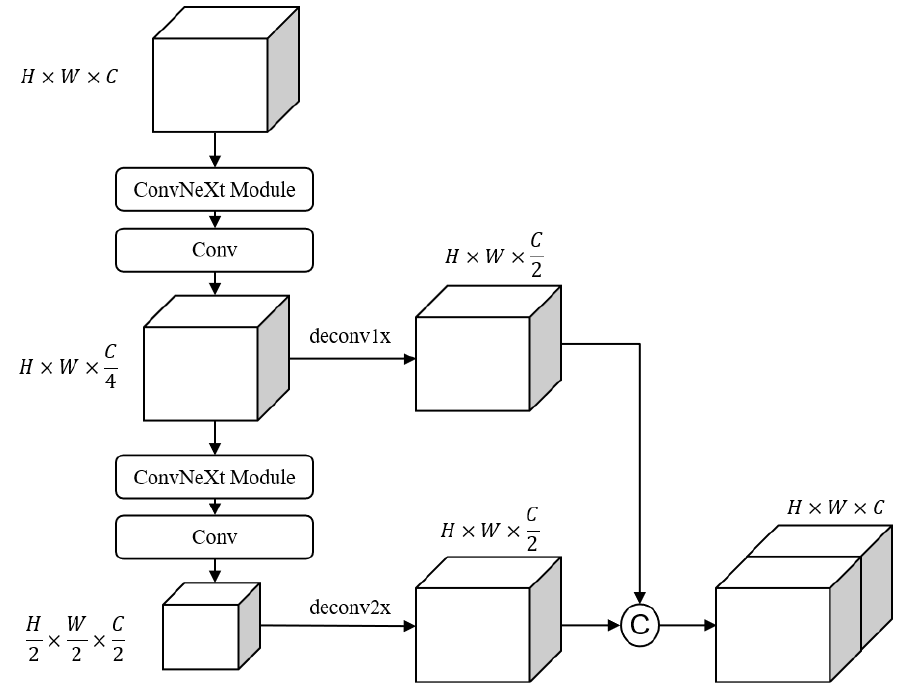
Figure 5. The structure of the MFF-ConvNeXt